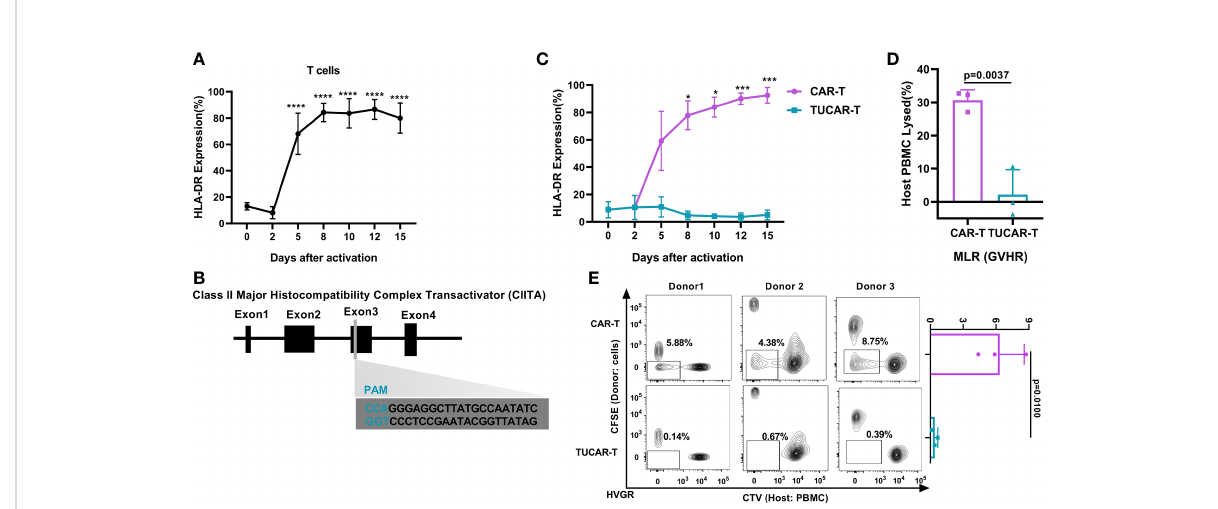
FIGURE 1 Ef fi cient and speci fi c editing of triplex genes in primary T cells. (A) HLA-DR was expressed continuously with the activation of T cells (n = 3). (B) Schematic diagram of the designed sgRNA targeting the human CIITA. (C) HLA-DR gene expression monitoring in TUCAR-T and unedited CAR-T cells with continued activation (n = 3). (D) (n = 3) and (E) (n = 3) Alloreactivities between donor TUCAR-T cells and PBMCs from the allogeneic donor were analyzed by the MLR assay. In GvHR, we showed the percentages of host PBMCs that died by rejection lysis (D) . In HvGR, the cells in the box represented host PBMCs proliferating from allogeneic CAR-T cell stimulation (E) . All data represent the mean ± SD with individual donors. Statistical signi fi cance was determined using one-way ANOVA with Dunnett ’ s correction for multiple comparisons (A) , two-way ANOVA with Sidak ’ s correction for multiple comparisons (C) , and two-tailed, paired or unpaired Student ’ s t -test (D, E) . Signi fi cances of p ≤ 0.05 are indicated by 1 asterisk (*), p ≤ 0.001 are indicated by 3 asterisks (***), p ≤ 0.0001 are indicated by 4 asterisks